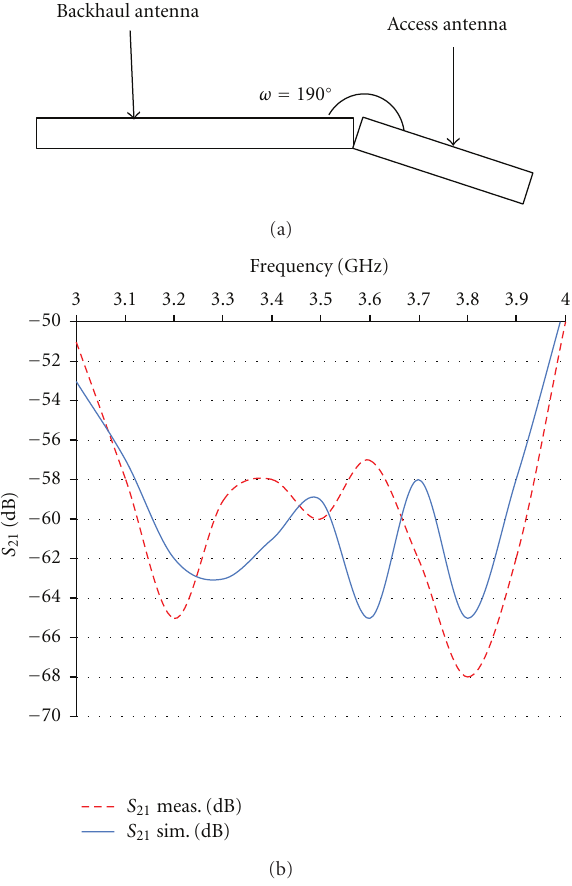
Figure 17: (a) Configuration for ω = 190 ◦ . (b) S 21 for ω = 190 ◦ . Table 3: S 21 variation for configuration 2. Figure 18: (a) Configuration for